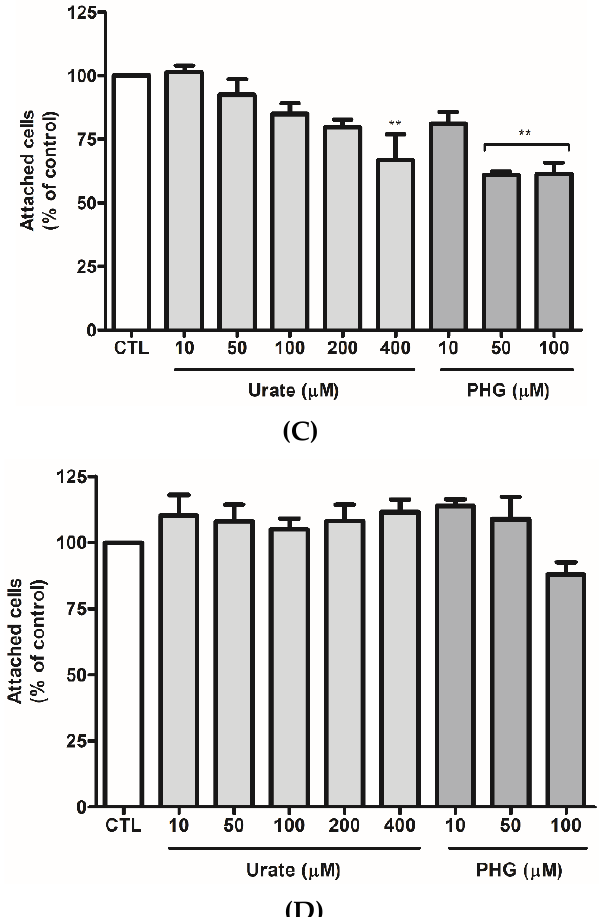
Figure 6. Urate and PHG reduce HUVEC migration ( A , B ) and adhesion ( C , D ). ( A , B ) HUVECs (5 × 10 5 cells/well) were seeded in 6-well plates. After 2 days, the culture medium was replaced by RPMI medium 0.2% BSA. After 24 h, a scratch was made in the cell monolayer. Cells were washed with PBS and incubated with RPMI medium 0.2% BSA (control), urate (10–400 µM), and PHG (10–100 µM) for 24 h. ( A ) Images of scratch were taken in an inverted light microscope (Nikon) using 4× magnification before and after incubation. Scale bar 100 µm. Representative images of 3 independent experiments. ( B ) The distance of the scratch was calculated using ImageJ software. The results are expressed as %migration = (initial scratch width − final scratch width)/initial scratch width *100% . ( C , D ) HUVECs (2.5 × 10 5 cells/well) were harvested and incubated with RPMI medium 0.2% BSA (control), urate (10–400 µM), and PHG (10–100 µM) while seeding for 24 h in 96-well plates without coating ( C ) or with gelatin coating ( D ). After incubation, cells were washed with PBS and stained with crystal violet. Each datum represents the mean ± S.E.M. (n = 3). Statistical analyses were performed by one-way ANOVA followed by Bonferroni’s post-test, * p < 0.05 ** p < 0.01 *** p < 0.001 compared to the control group. PHG: phloroglucinol.